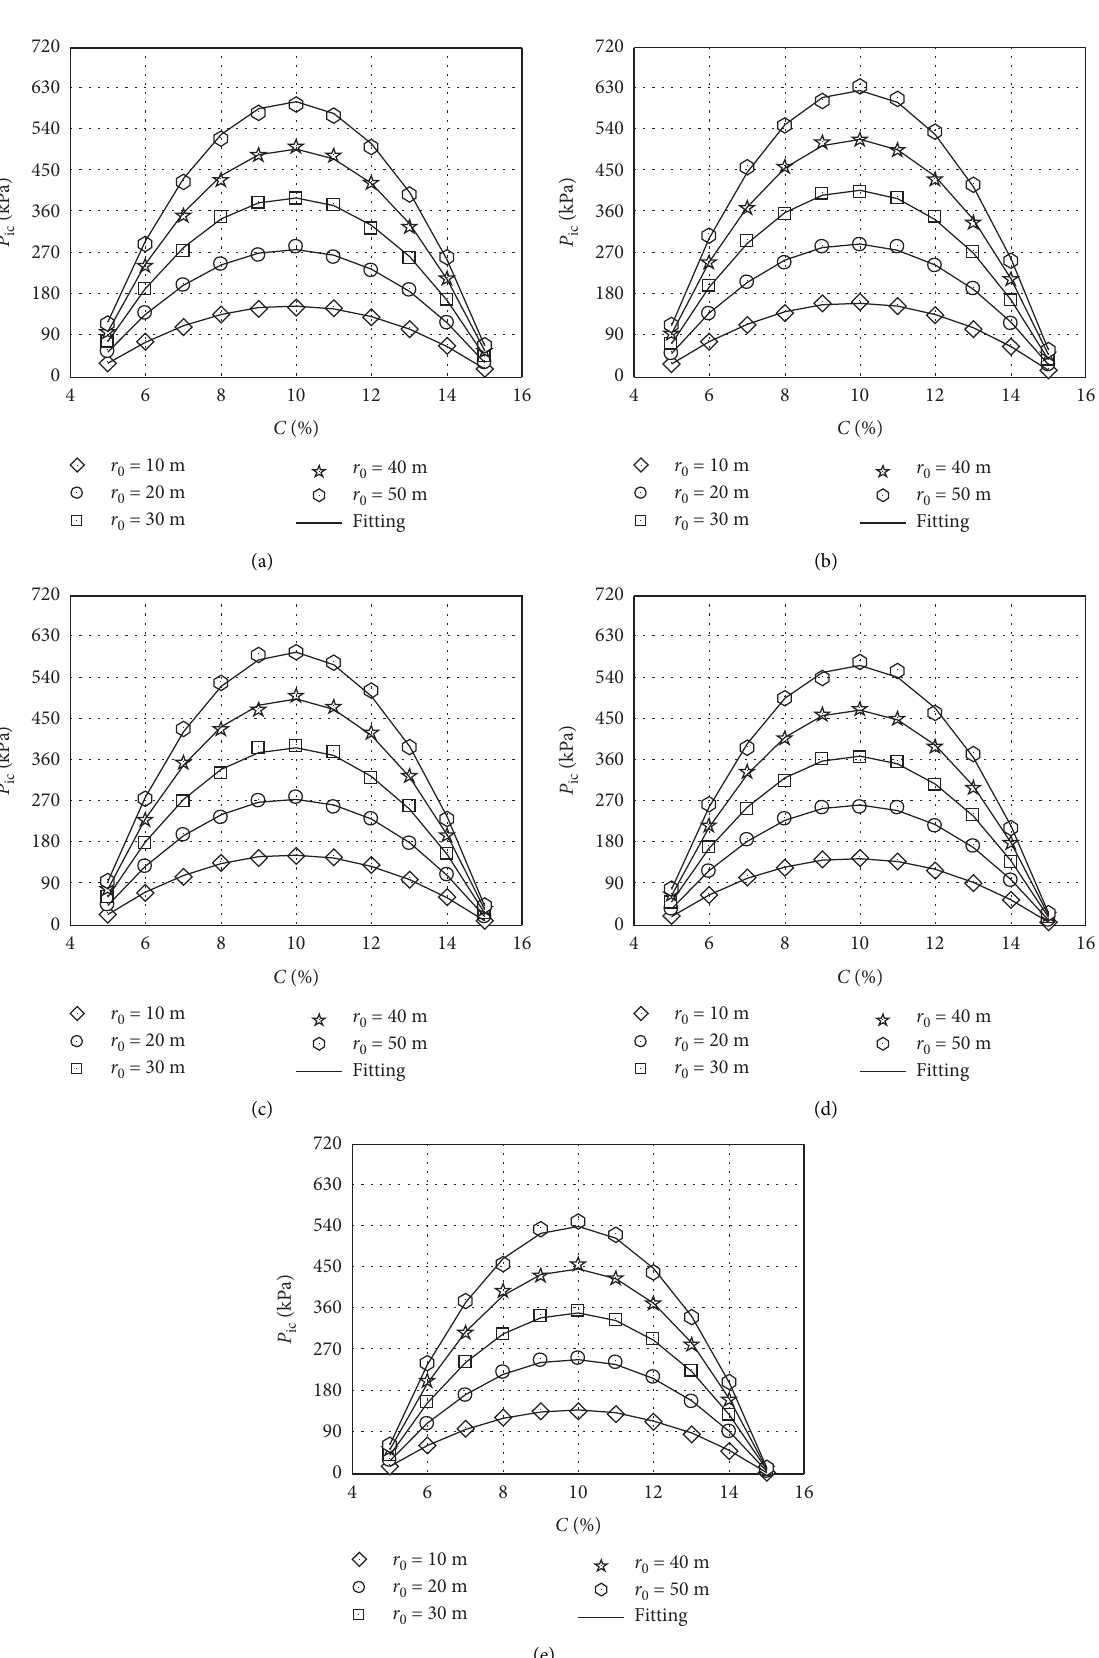
� − 60 ° C. (b) T � -30 ° C. (c) T � +0 ° C.